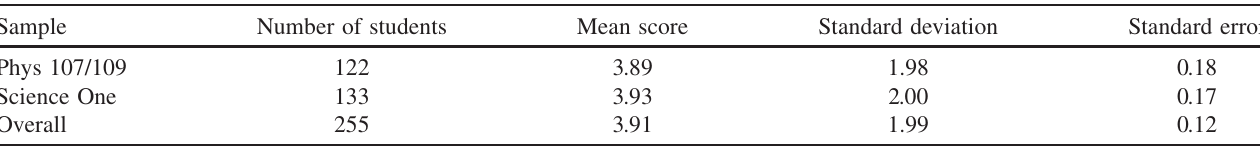
TABLE II. UBC post-test